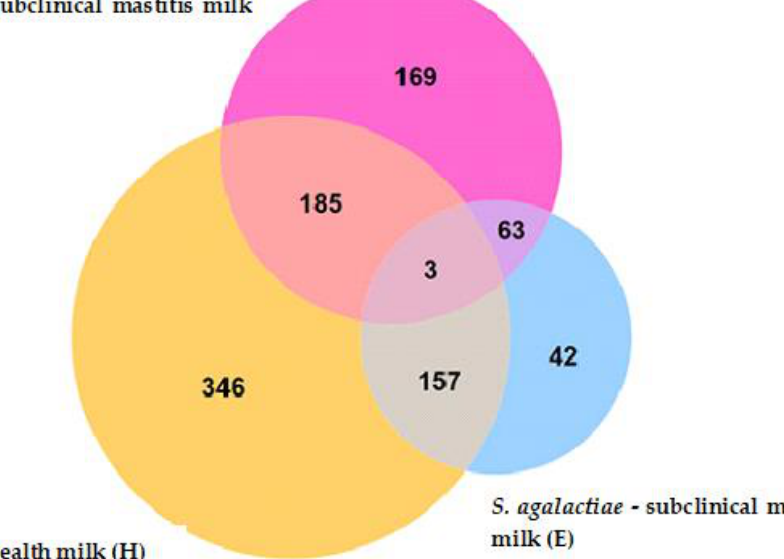
Figure 4. Venn diagram of the microorganisms shared among the milk metagenome. H, healthy milk; M, S. agalactiae subclinical mastitis milk; E, E. coli subclinical mastitis milk.